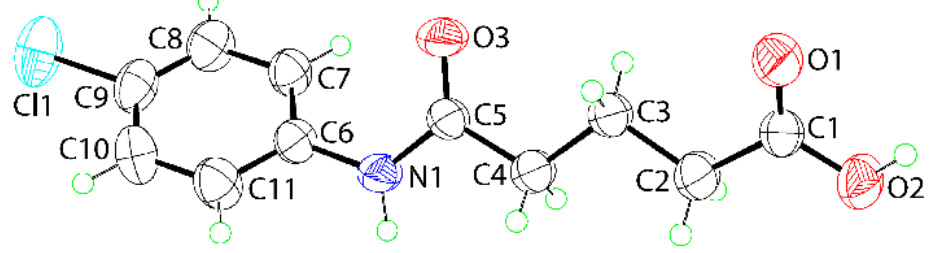
Figure 1. The molecular structure of ( 1 ) showing atom labeling and displacement ellipsoids at the 50% probability level.